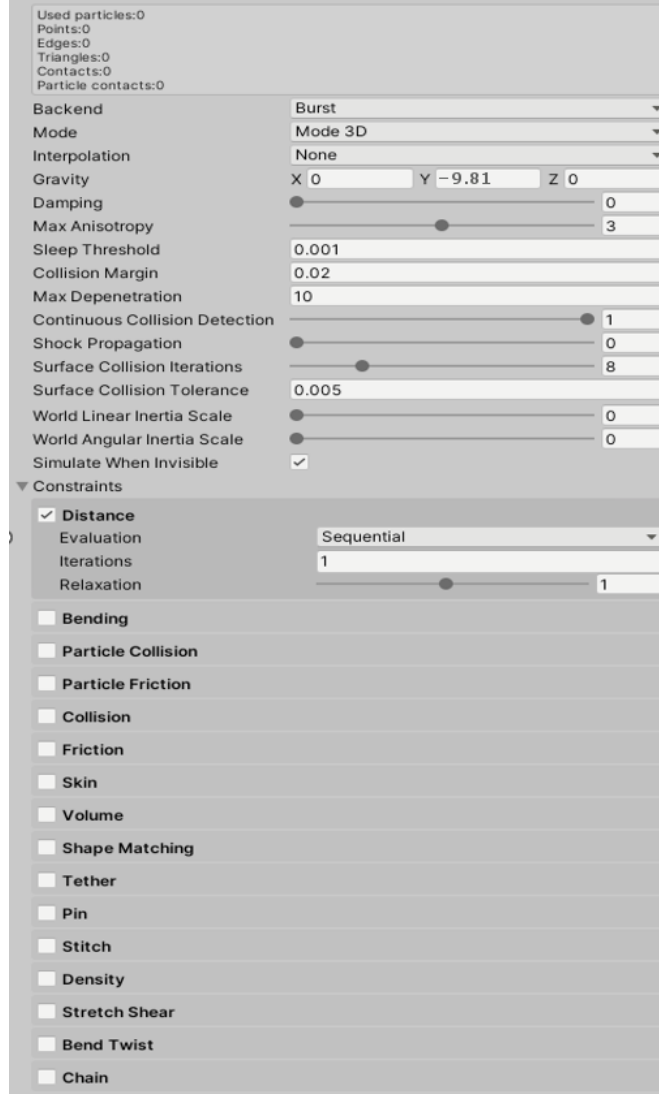
Figure 25. “ Obi Rope ” component. Figure 25. “Obi Rope”